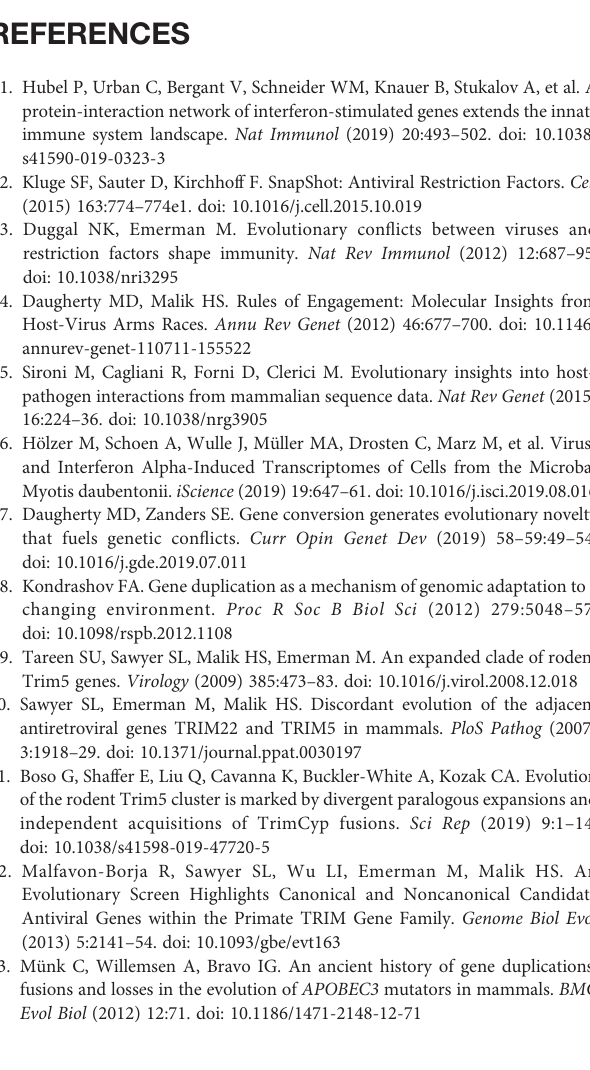
SUPPLEMENTARY FIGURE 1 | Maximum likelihood phylogenetic tree generated with the whole coding sequences of HERC5 , HERC6 , and HERC3 nucleotide alignment from artiodactyl, carnivore, rodent, bat, and primate species. Asterisks indicate bootstrap values greater than 80%. The scale bar represents the proportion of genetic variation (0.2 for the scale), and is indicated at the bottom. Sequences are collapsed in each order for better readability. SUPPLEMENTARY FIGURE 2 | Pseudogenization of cetacean HERC6 (A) . Multiple amino acid alignment of six cetacean HERC6 sequences showing multiple substitutions, insertions, and deletions (B). Multiple nucleotide alignment with corresponding amino acids of cetacean, rodent, bat, ruminant, primate, and